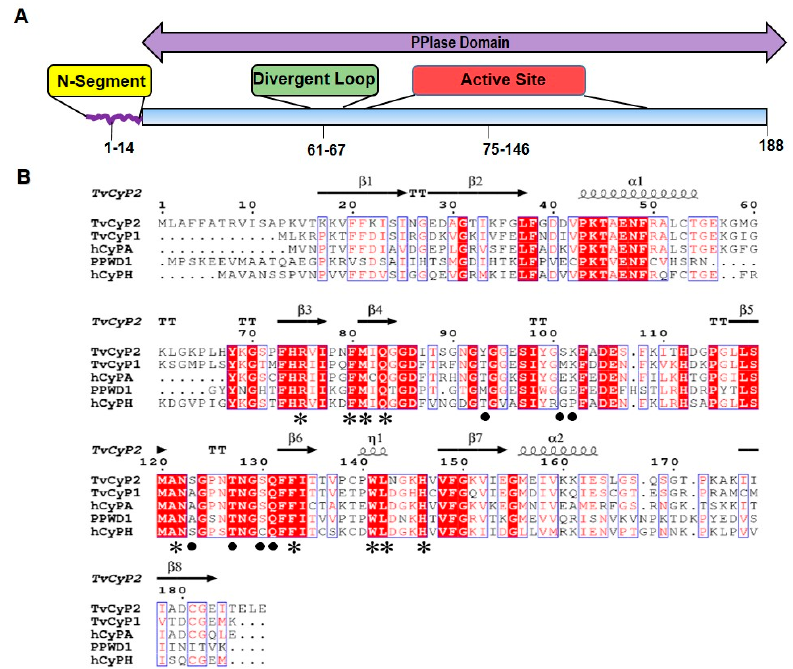
Figure 1. ( A ) A schematic representation showing the positions of N-terminal segment, divergent loop and the active site in T. vaginalis cyclophilin 2 ( Tv CyP2). ( B ) Sequence alignments of Tv CyP2 with the cyclophilins mentioned in this article, including Tv CyP1, human cyclophilin A ( h CyPA), h PPWD1, and h CyPH, which share 69%, 64%, 48%, and 56% sequence identity with Tv CyP2, respectively. The conserved residues are shown in white with a red background and similar residues in red with white background. The secondary structures of Tv CyP2 are on top of the sequence, and residues in S1 pocket (active site) and S2 pocket are indicated by an asterisk and circle, respectively, on the bottom of the sequence. The alignment was generated by using Clustal Omega and ESPRIPT.